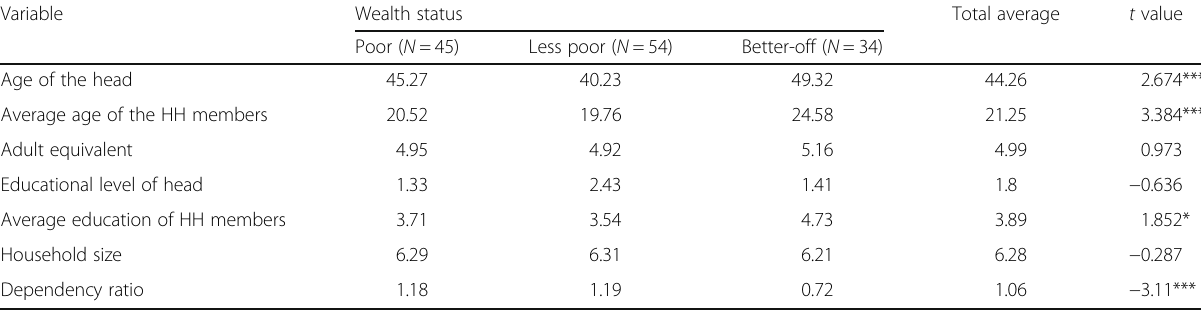
Table 1 Demographic characteristics of sample households ( N = 133) Variable Wealth